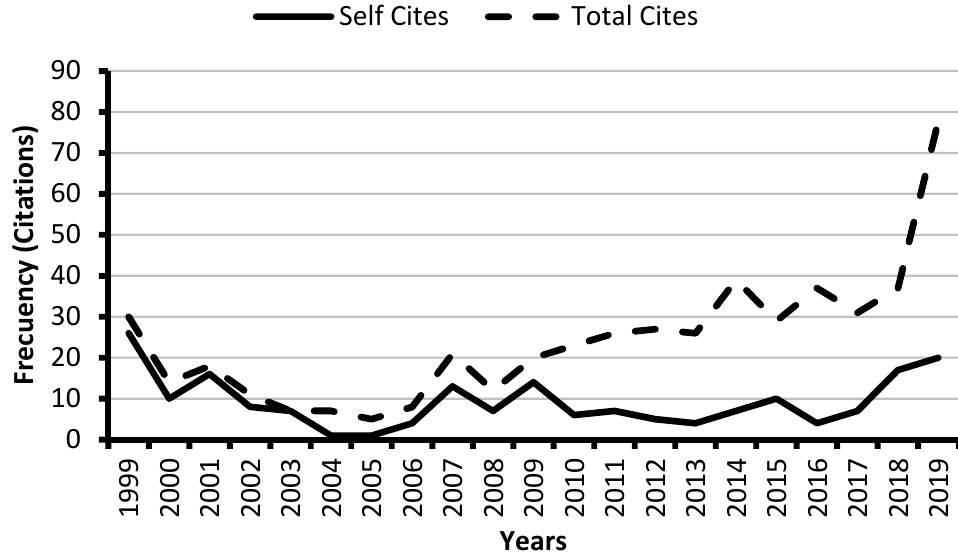
Figure 3. Self-cites vs. total cites.